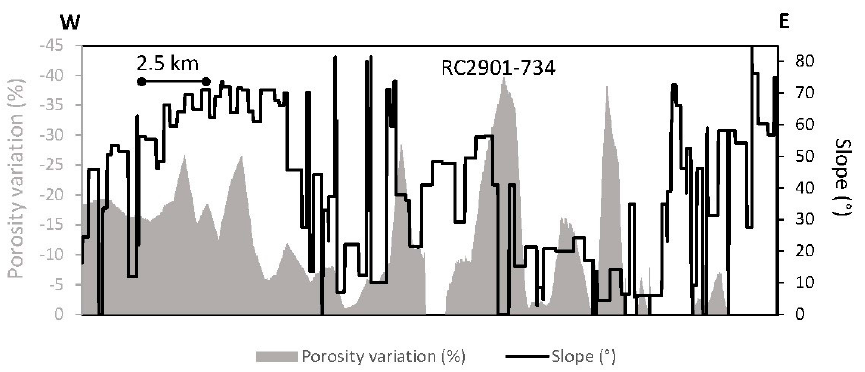
Figure 6. Porosity variations due to a gas hydrate presence (grey area) and slope variation (black line) along the line RC2901-734.